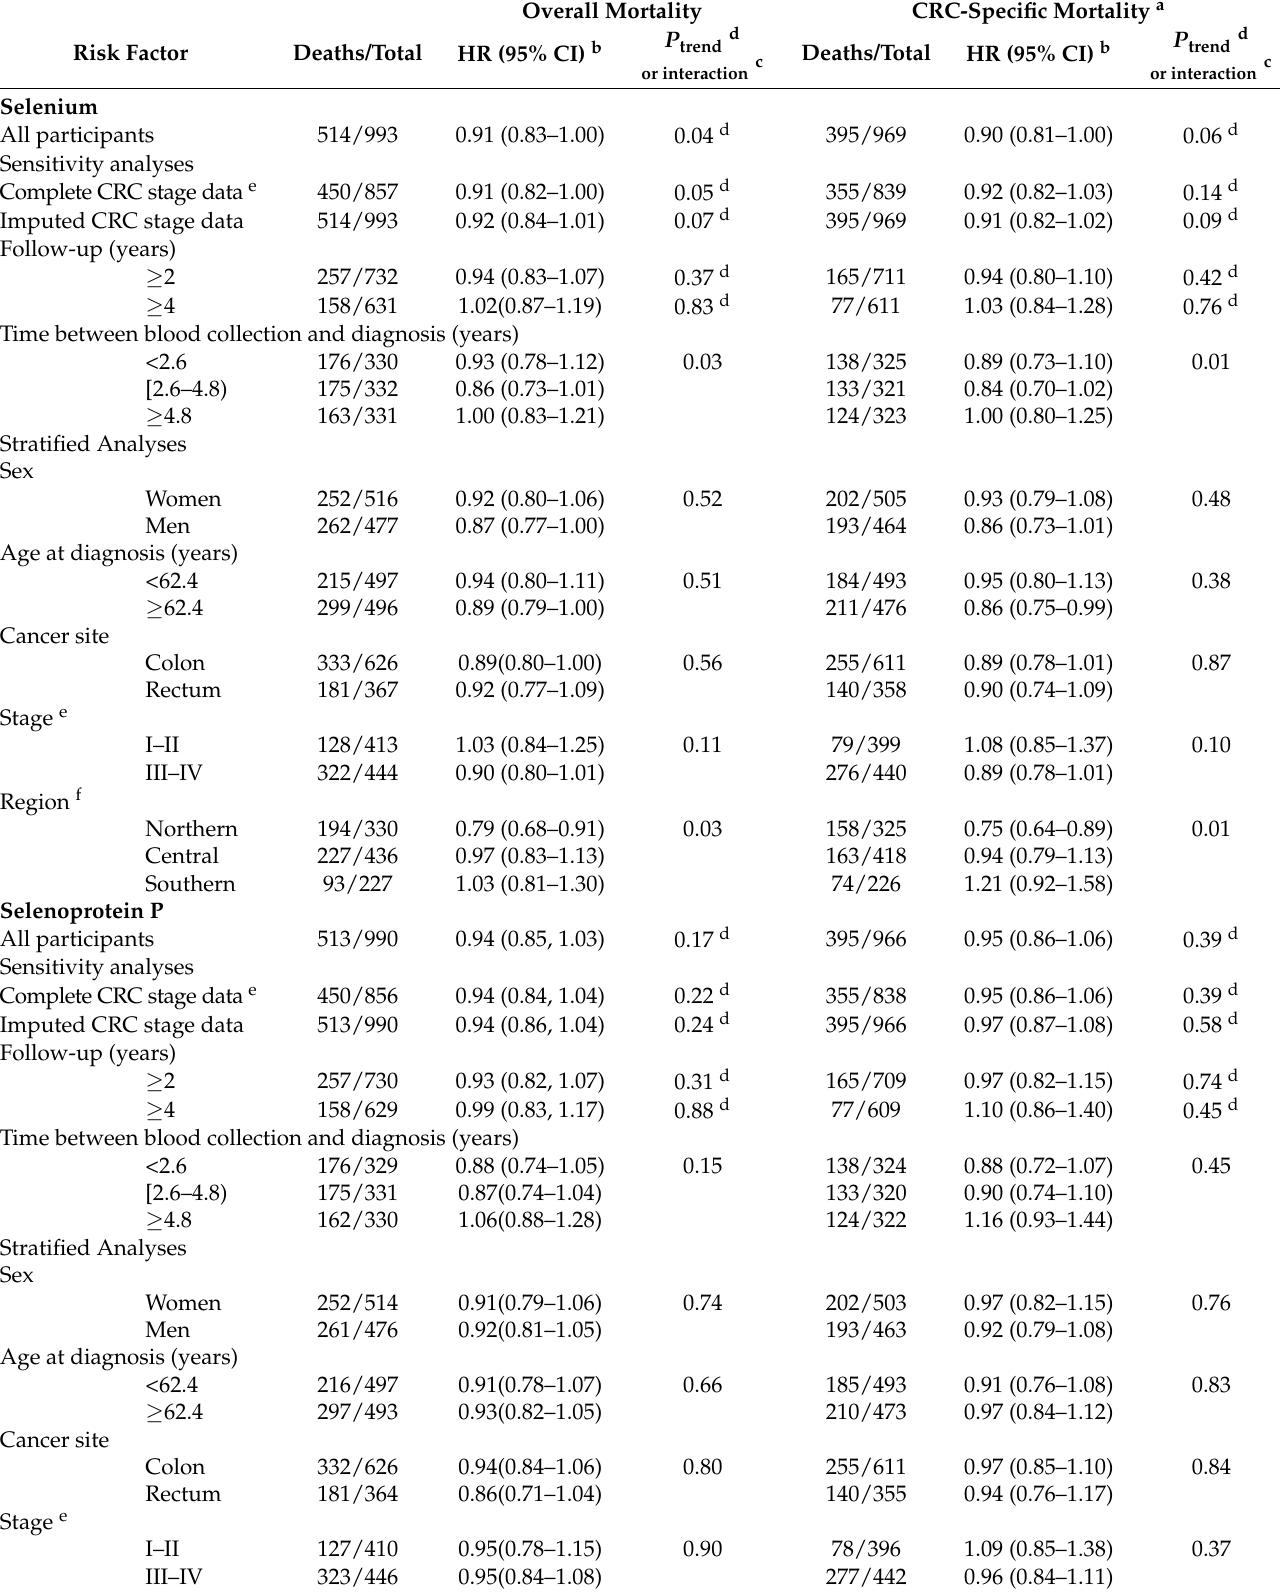
Table 3. Multivariable-adjusted HRs and 95% CIs for an increment of one SD of Se or SELENOP for overall and CRC-specific mortality in sensitivity analyses and across strata of potential effect modifiers among CRC cases in the EPIC